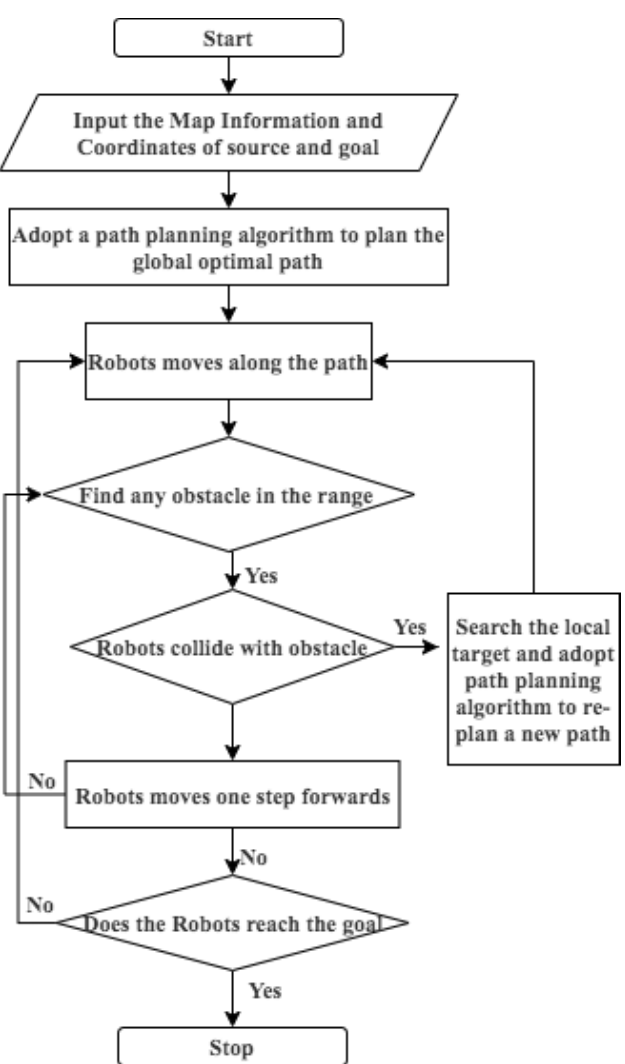
Figure 1. Proposed model as flow of path-planning